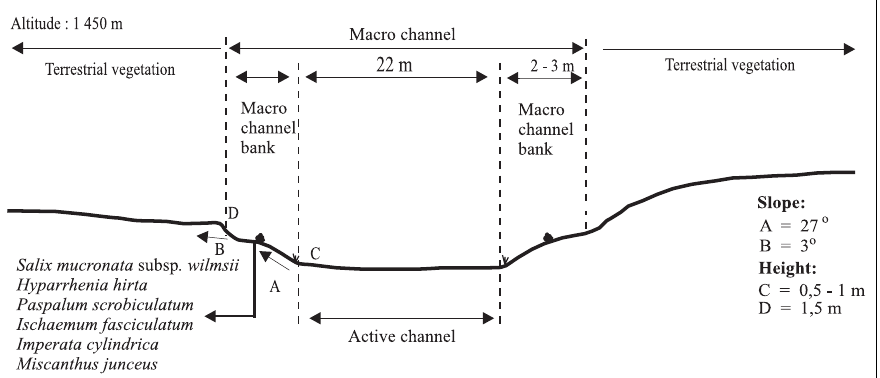
Fig. 8. River profile of the Paspalum scrobiculatum-Miscanthus junceus variant.